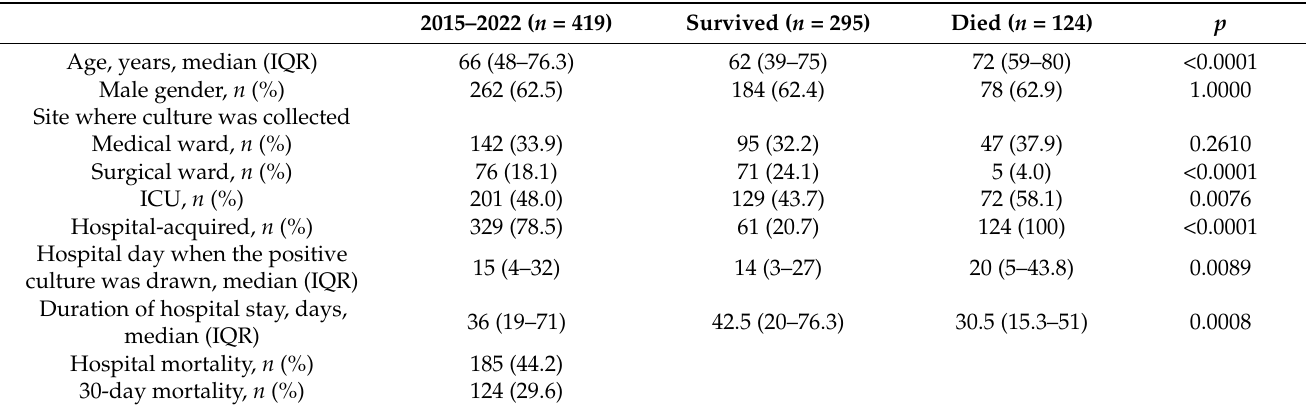
Table 1. Characteristics of patients with Pseudomonas spp. bacteremia in all patients and in regard to mortality at 30-days.